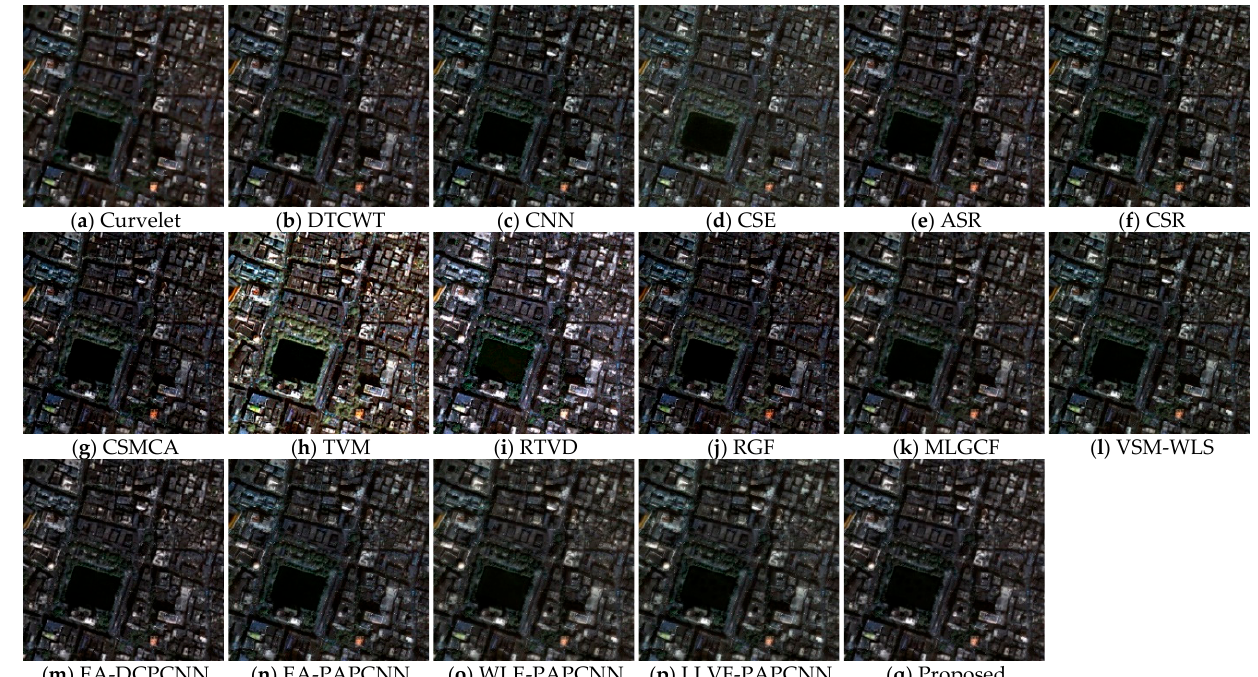
Figure 5. Fusion effect of QuickBird image.